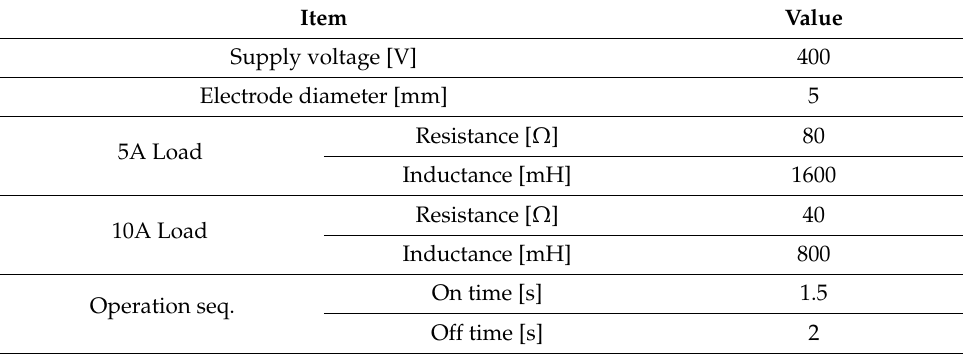
Table 2. Contact electrode aging test